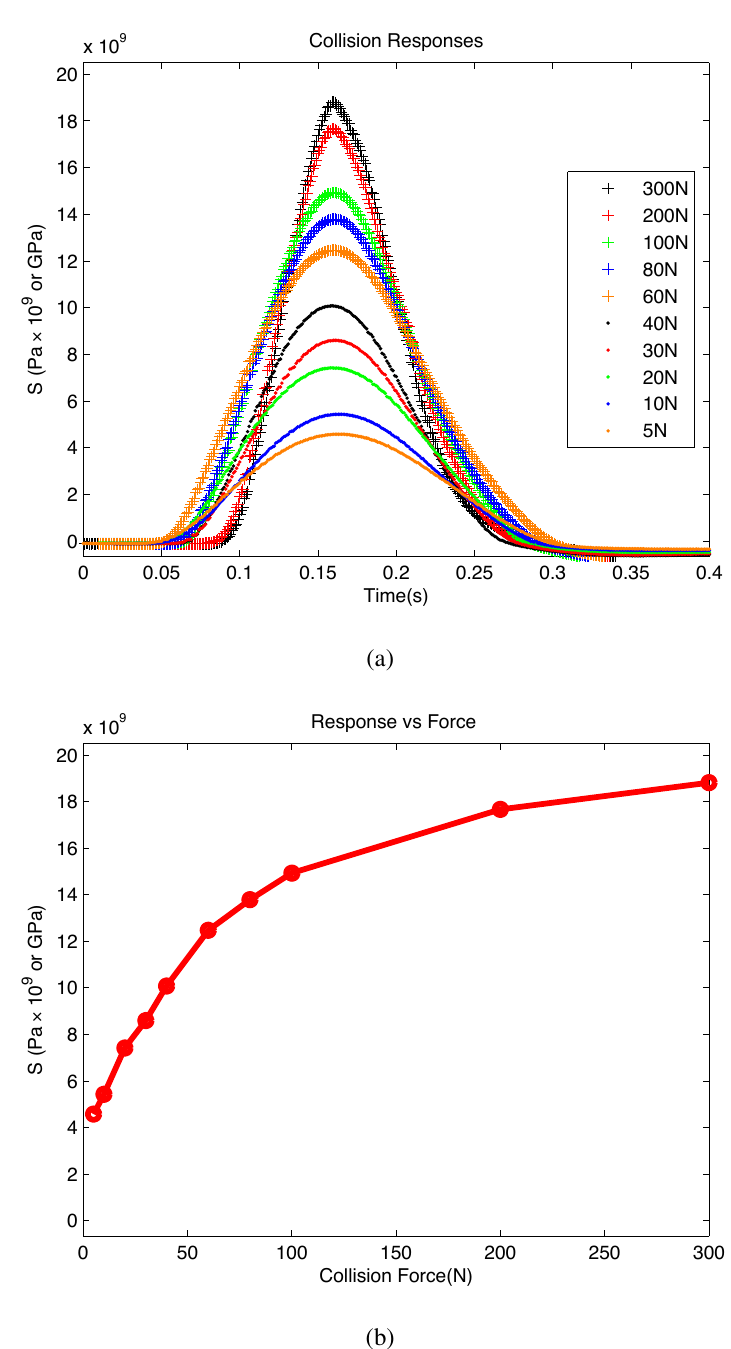
Figure 4. Results from sensor mounted on a planar surface. ( a ) Mean captured results for wide dynamic range of collision stimuli; ( b ) The relation of measured collision to force of object